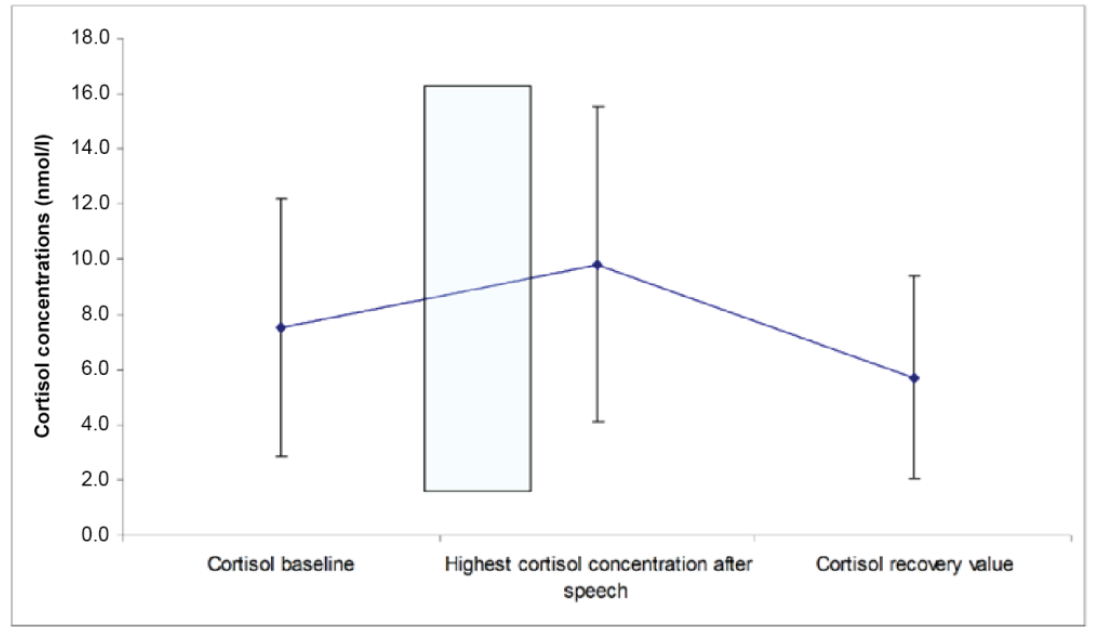
Figure 4. Cortisol response to the public speaking task.